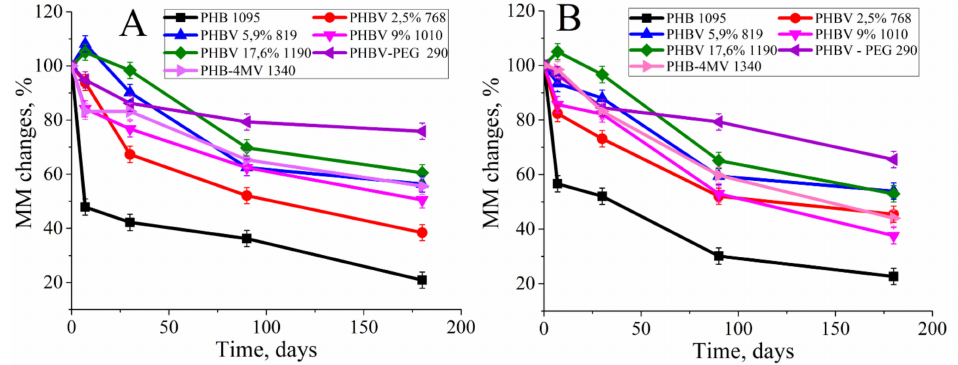
Figure 2. The change in the molecular mass of PHB, PHBV (with a di ff erent molar content of HV), PHB-4MV, PHBV-PEG films during hydrolytic ( A ) and enzymatic degradation ( B ) for 6